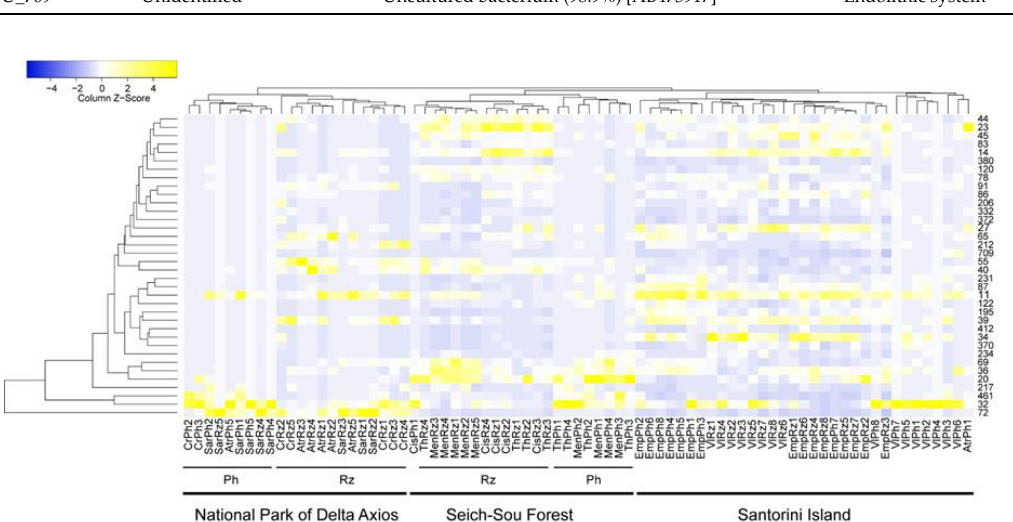
Figure 5. Multidimensional scaling plot of non-transformed OTUs number of reads in all samples (rhizosphere and phyllosphere samples of all individuals sampled), according to Jaccard similarity index. See Table 1 for coding assignments.